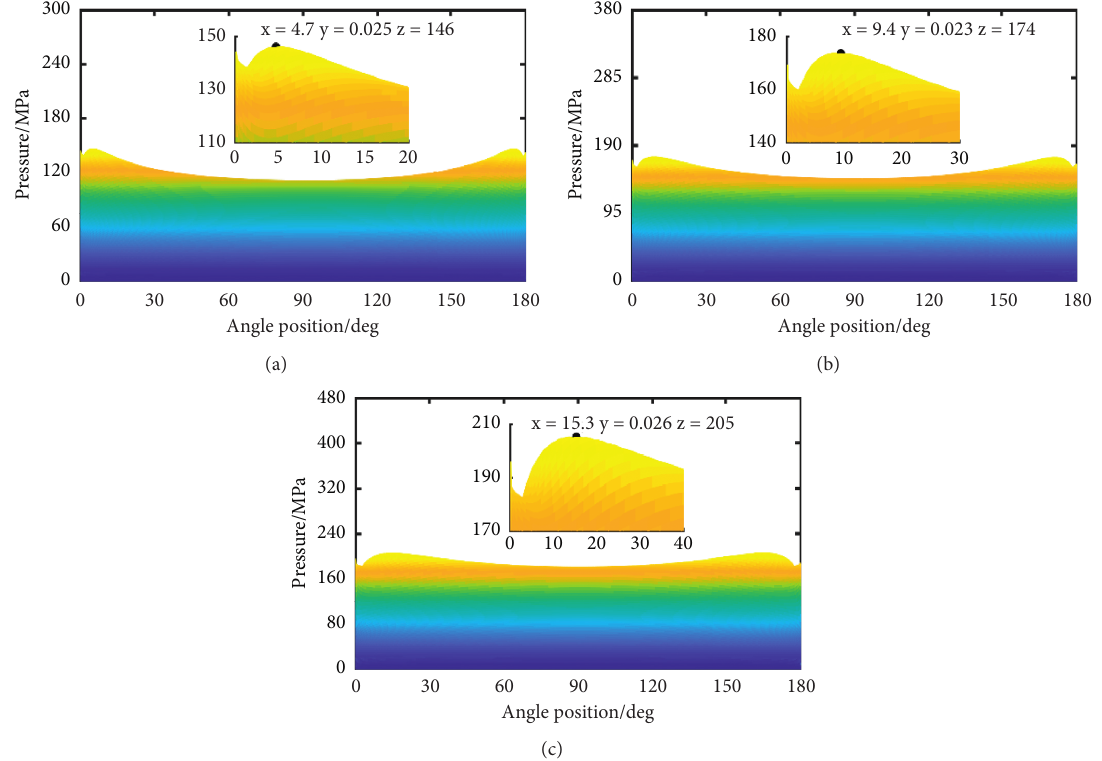
Figure 7: The effect of discharge pressure on the local maximum pressure distribution at n � 700 r/min. (a) p � 10 MPa; (b) p � 15MPa; (c) p � 20MPa.